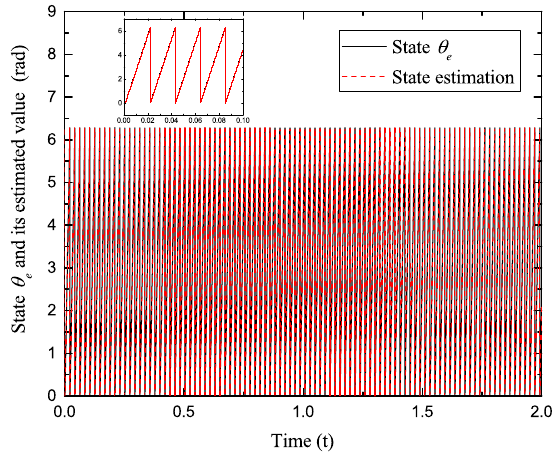
Figure 3. State θ e and its estimated value ˆ θ e .